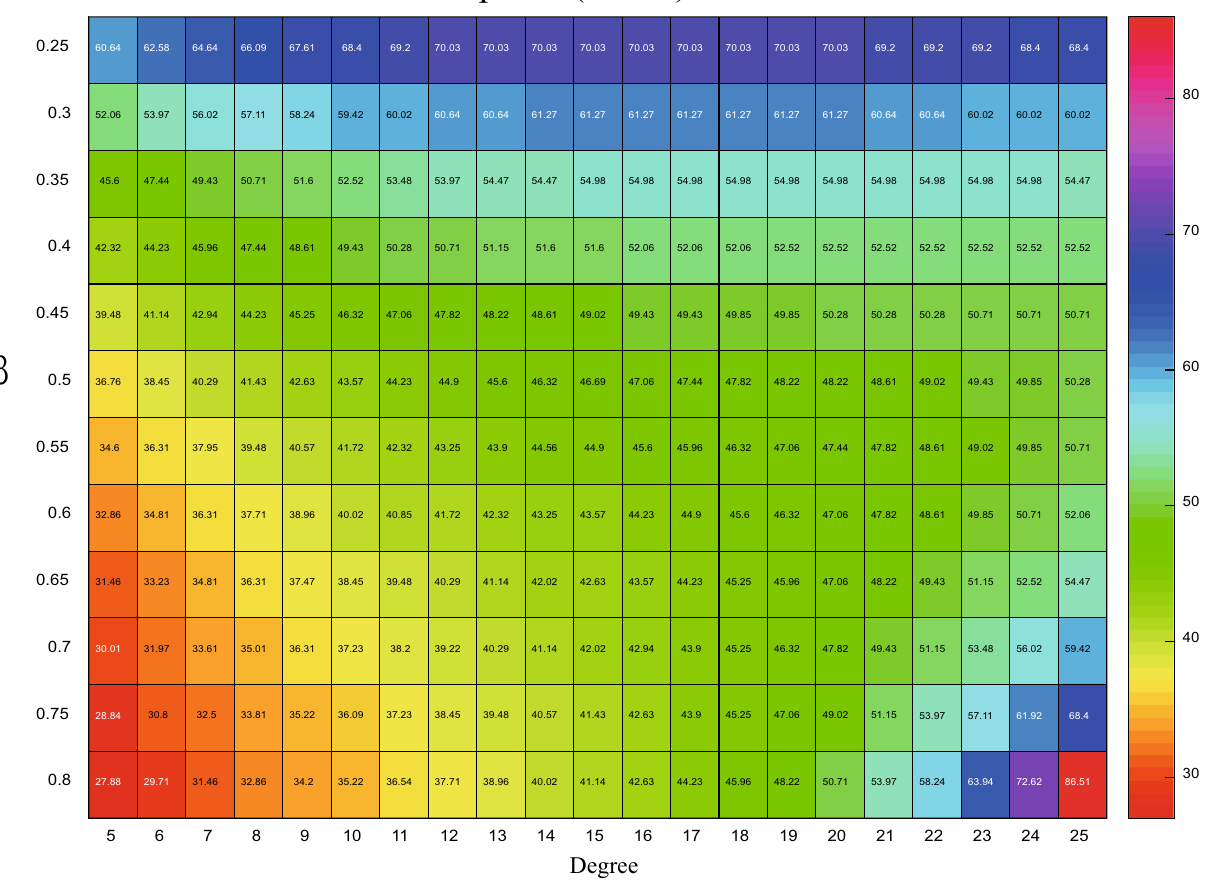
Figure 6. The period of H with different degree and β , when ρ = 0.004